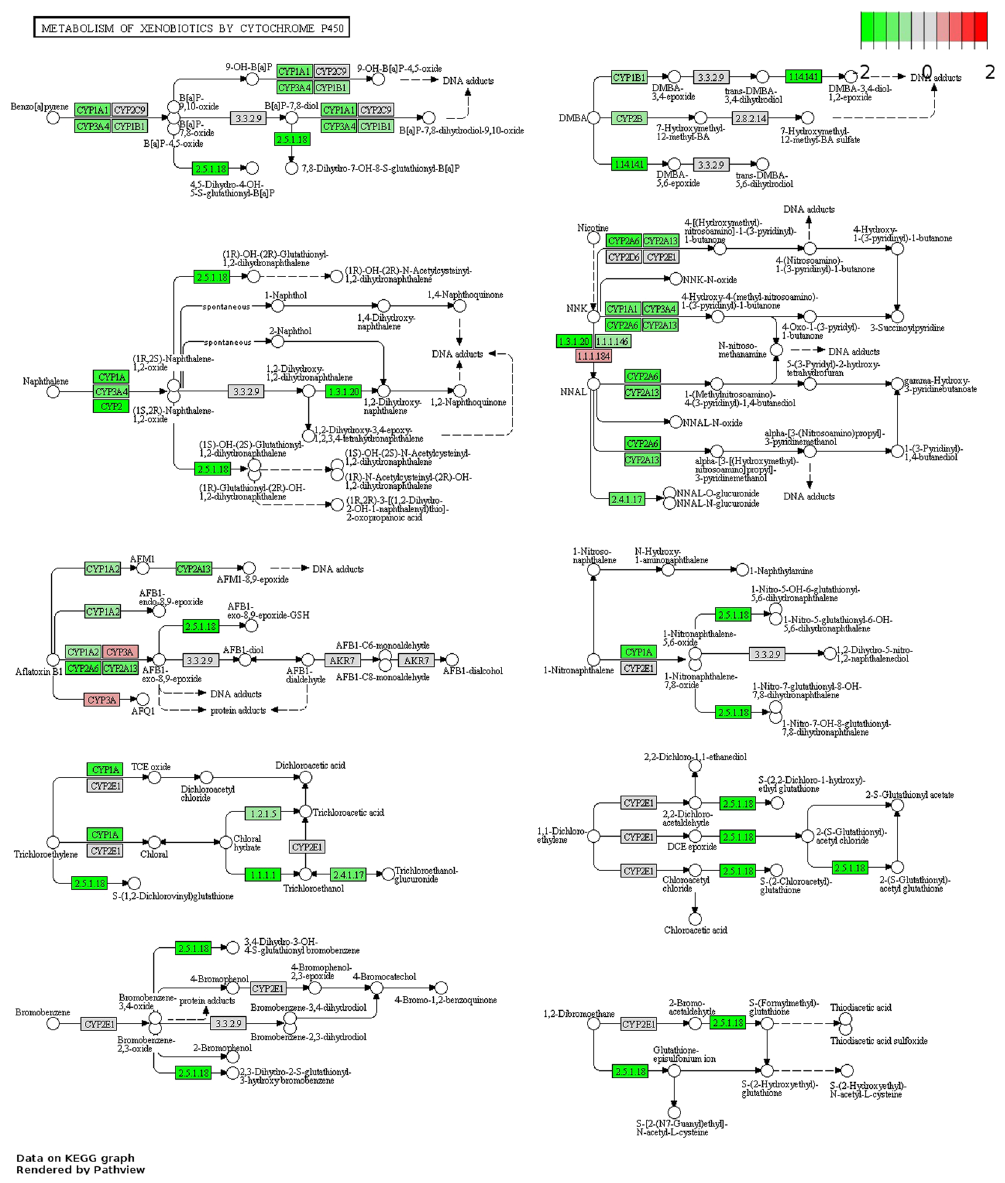
Figure 4. Differential gene expression in xenobiotics metabolism pathway between Asian American and Caucasian American. Up or down regulation means increase or decrease of gene expression in Asian American BRCA patient tumor tissues. The pathway diagram with differential gene expression was made using Pathview package 47 , where pathway diagrams were originally obtained from KEGG database 18–20 .